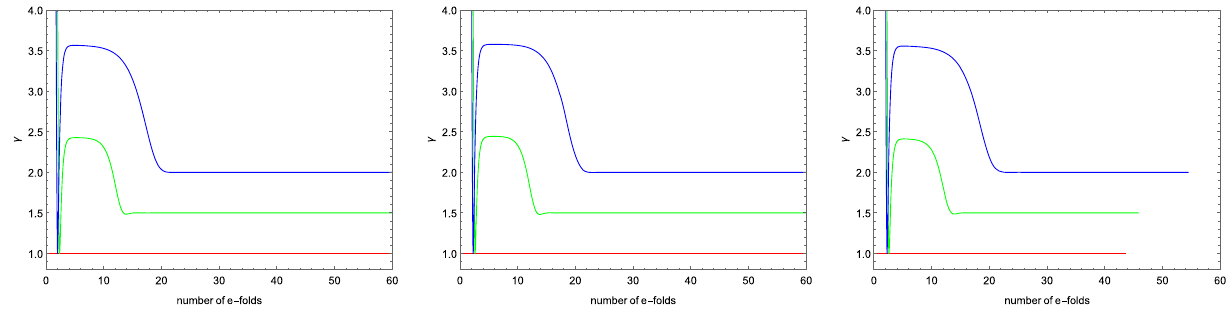
Fig. 4 Time evolution of γ( t ) for three different values of γ 0 . These plots clearly show that all γ( t ) converge exactly to their corresponding γ 0 , confirming the attractive property of the solution